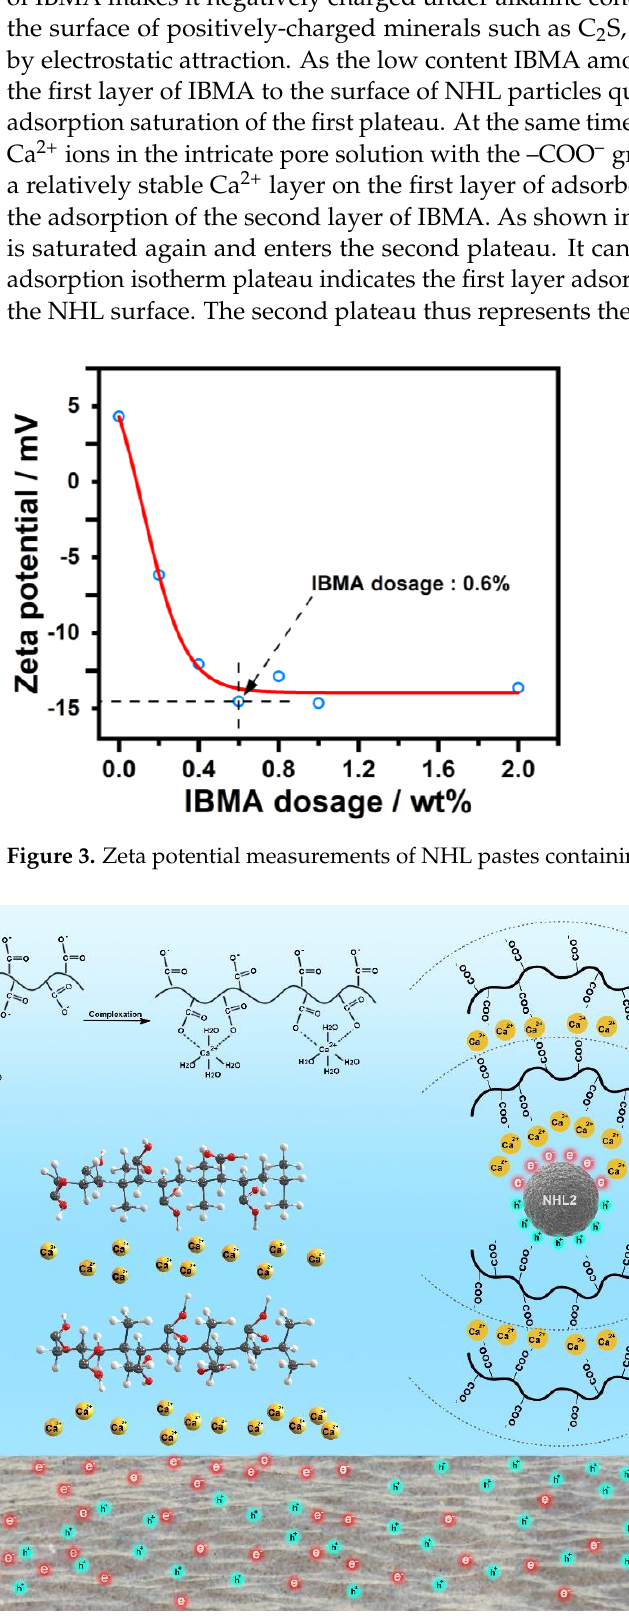
Figure 4. Schematic diagram of the structure of the chelate complex of